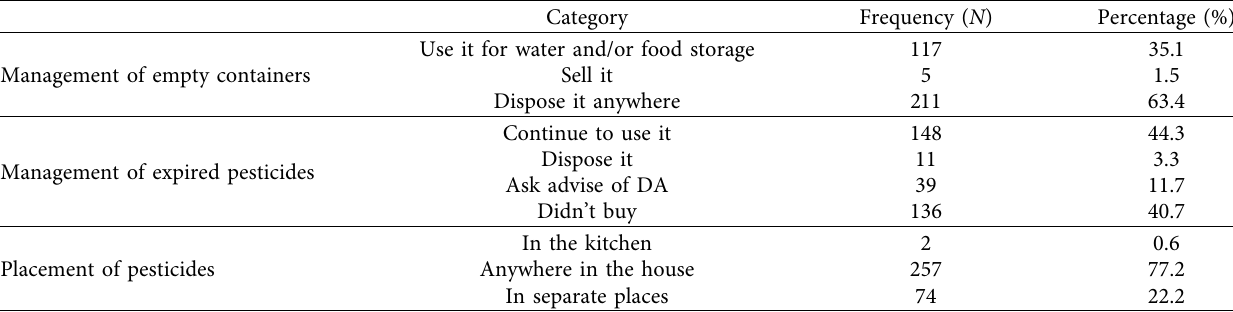
Table 11: Management of empty containers, expired pesticides, and storage of pesticides.